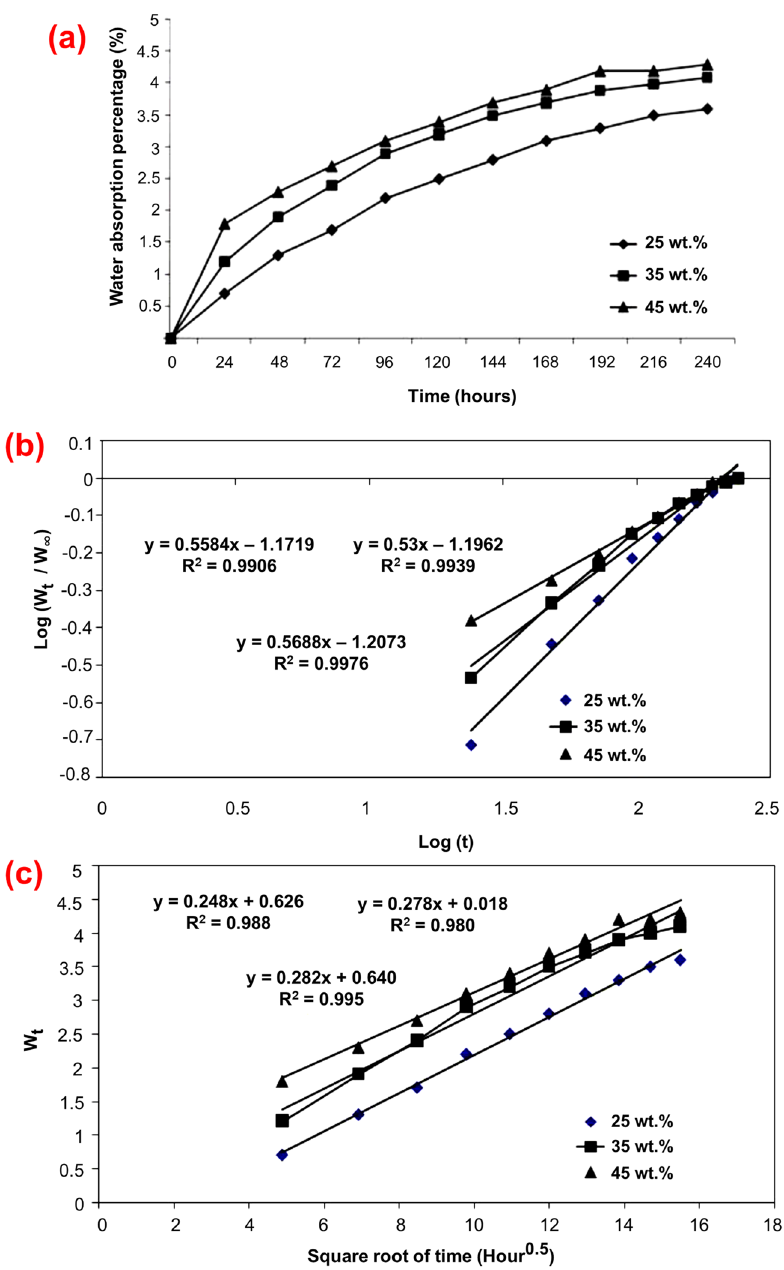
Figure 2. ( a ) The water absorption percentage versus (vs.) immersion time curves of CGF/AFF/PF hybrid composites, ( b ) diffusion curve fitting plots for CGF/AFF/PF hybrid composites, and ( c ) diffusion curve fitting plot between Wt and square root of time for CGF/AFF/PF hybrid